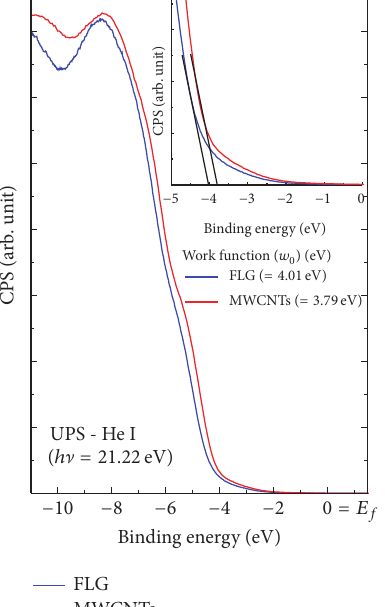
Figure 4: UPS spectra (He I = 21.22 eV) of graphene and MWCNTs. Estimated work functions of FLG and MWCNTs are 4.01 eV and 3.79 eV, respectively.